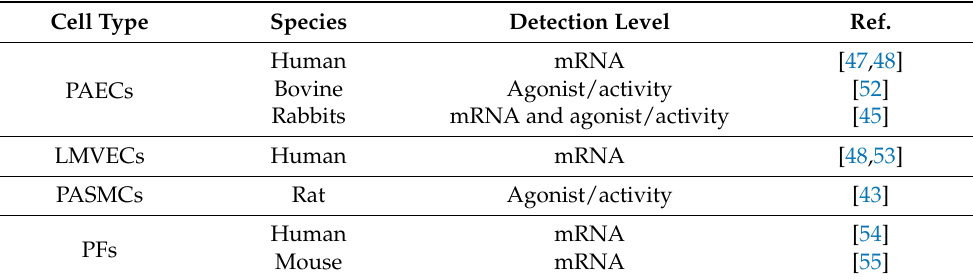
Table 1. Expression of P2Y2 receptors in the pulmonary